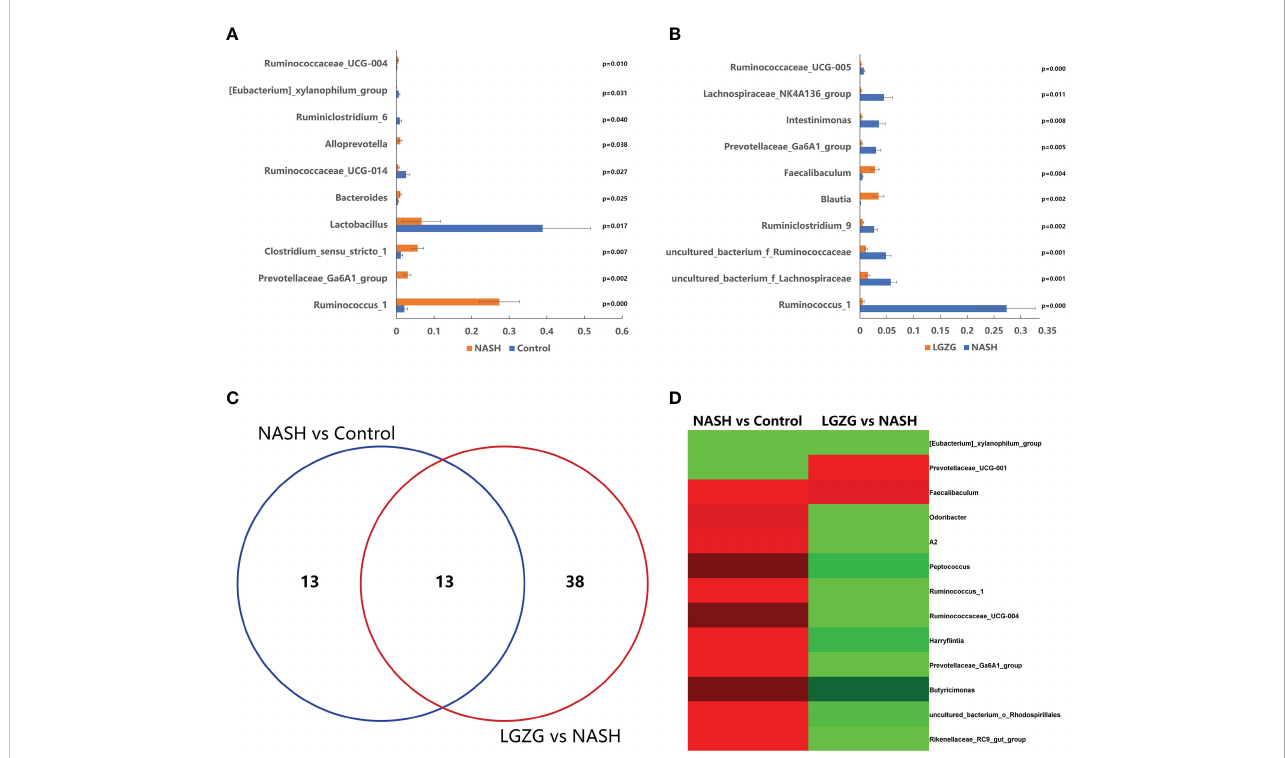
FIGURE 4 Signi fi cantly altered gut microbiota on the genus level among groups. (A) . The 10 representatives signi fi cantly changed genera between the Control and NASH groups; the X-axis represents relative abundance and Y-axis represents the genus name, (B) . The 10 representatives signi fi cantly changed genera between the NASH and LGZG groups; the X-axis represents relative abundance and the Y-axis represents the genus name, (C) . Venn diagram between pairwise groups (NASH vs. Control and LGZG vs. NASH), (D) . Hierarchical cluster of overlapped microbiotas between pairwise groups (NASH vs. Control and LGZG vs. NASH); the red color indicates up-regulated microbiota and the green color indicates down-regulated